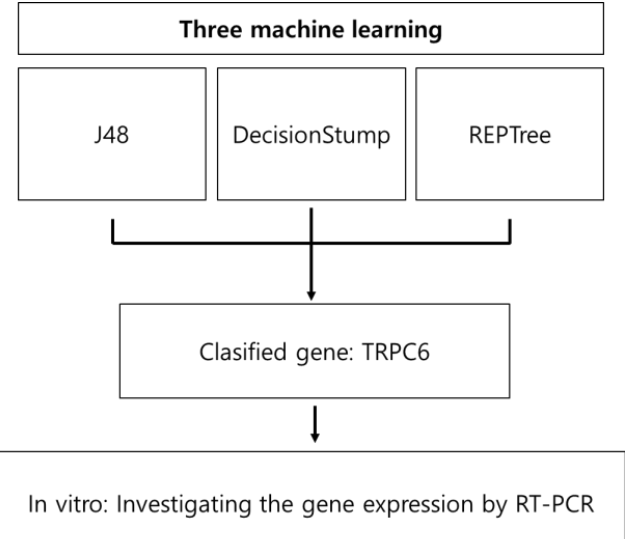
Figure 1. Overview of the experimental workflow.